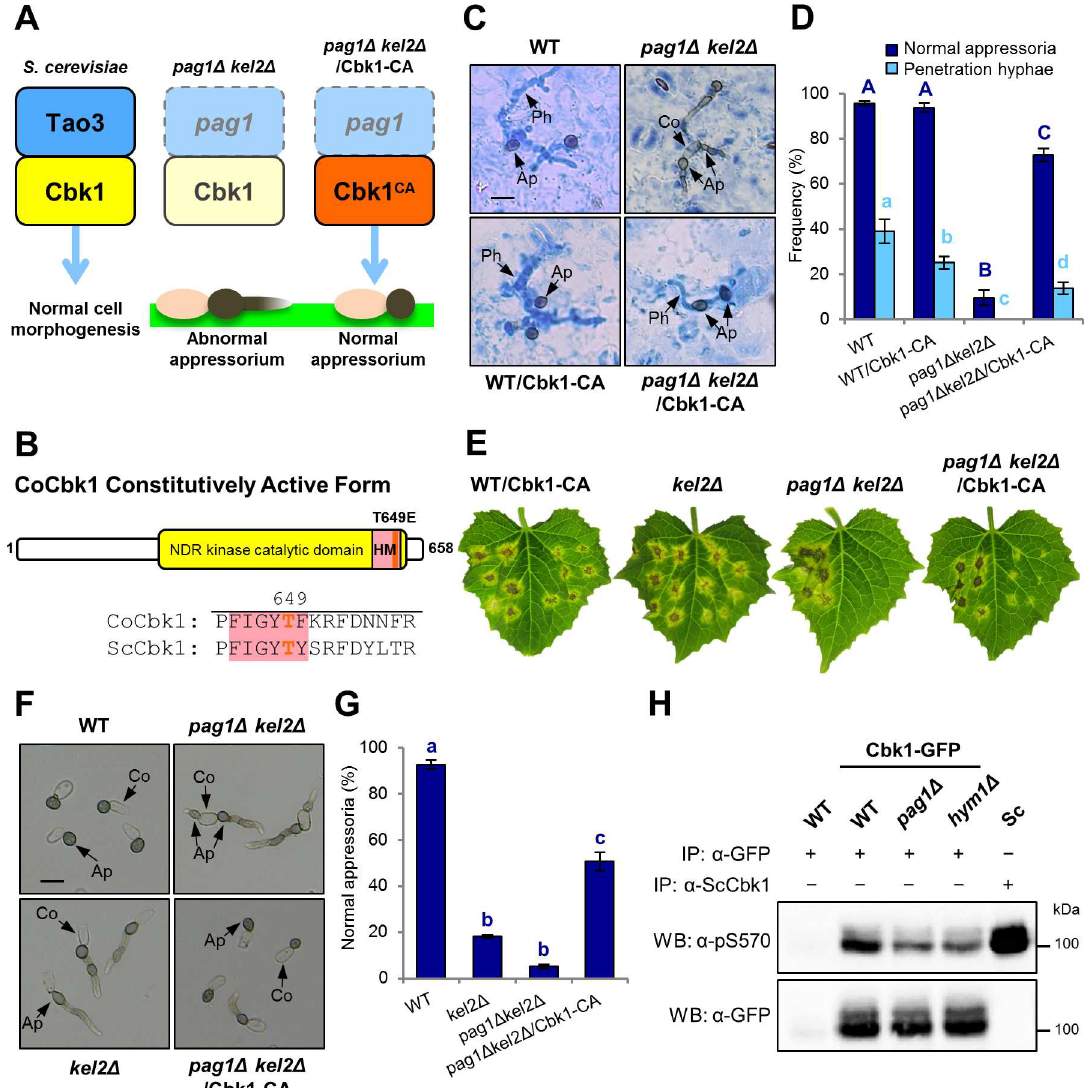
Fig 3. CoPag1 regulates the CoCbk1 activity. (A) Normal appressorium formation of copag1 Δ cokel2 Δ was restored by introducing the CoCbk1 constitutively active (CA) form. (B) Schematic drawing of CoCbk1 constitutively active (CA) protein and sequence alignment of C . orbiculare (Co) Cbk1 with corresponding sequences of S . cerevisiae (Sc) Cbk1. The kinase domain, the hydrophobicmotif (HM) and the site of the amino acid exchange (T649E) are marked. (C) Infection structures of CoCbk1-CA strains on lower surface of detached cucumber cotyledons at 3 d after inoculation. Penetration hyphae were stained with lactophenolaniline blue. WT, wild type strain 104-T; copag1 Δ cokel2 Δ , copag1 and cokel2 double mutant strain; WT/ CoCbk1-CA, CoCbk1-CA strain in WT background; copag1 Δ cokel2 Δ / CoCbk1-CA, CoCbk1- CA strain in copag1 Δ cokel2 Δ background. Co, conidium; Ap, appressorium; Ph, penetration hypha. Scale bar, 10 μ m. (D) Mean percentage ( ± SE) of normal appressorium formation and penetration hyphal formation on lower surface of cucum- ber cotyledons. At least 300 appressoria on three cotyledons were observed in each of three independent experiments. Values are means of three replications. Bars with different letters indicate significant differences (Tukey’s test; P < 0.01). (E) Pathogenicity assay of CoCbk1-CA strains on intact cucumber leaves after 7 d at 24˚C. Six drops of a conidial suspension was dropped onto one half of detached cucumber leaves; left sides: wild type; right sides: indicated mutant. (F) Appressorium development of CoCbk1-CA strains on petri dishes after 24 h at 24˚C. Conidialsuspensions of strains were prepared with distilled water. Scale bar, 10 μ m. (G) Mean percentage ( ± SE) of normal appressorium formation of CoCbk1-CA strains on polystyrene petri dishes at 24 h after inoculation. At least 300 appressoria on a petri dish were observed in each of three independent experiments. Values are means of three replications. Bars with different letters indicate significant differences (Tukey’s test; P < 0.01). (H) CoCbk1 phosphorylation in copag1 Δ and cohym1 Δ . CoCbk1-GFP (102 kDa) was immunoprecipitated with anti-GFP from mycelia of the indicated strains. S . cerevisiae (Sc) Cbk1 (95 kDa) immunoprecipitated with anti-ScCbk1 was used as a positive control. The proteins were detected by western blotting using phosphospecific anti-pS570 (top) and anti-GFP (bottom).